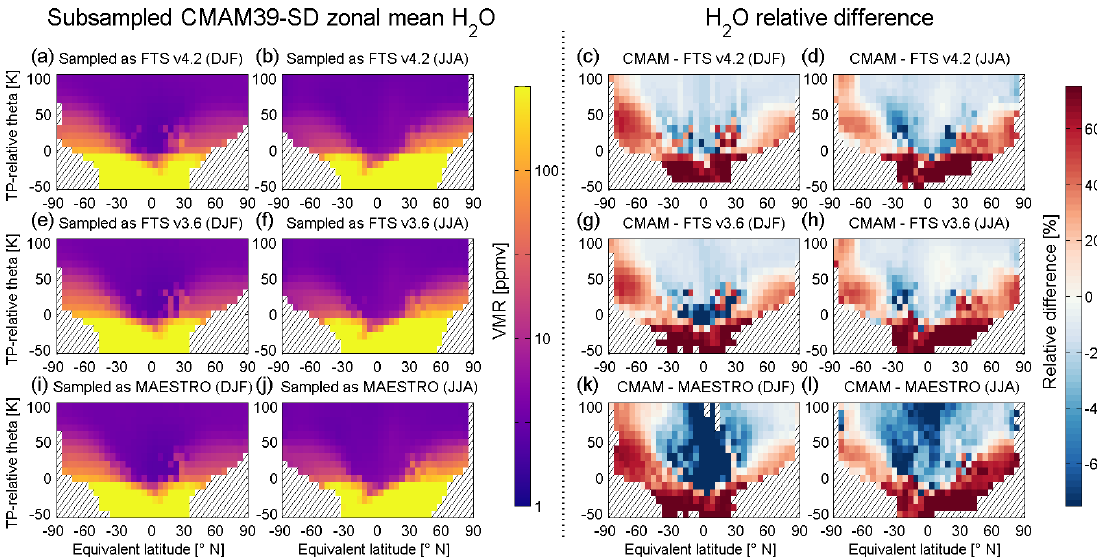
Figure 2. Comparisons between the CMAM39-SD model simulation, subsampled to the times and locations of the ACE-FTS v4.2 (a–d) , ACE-FTS v3.6 (e–h) , and MAESTRO (i–l) measurements and the satellite datasets. The zonal-mean multiyear-mean subsampled climatolo- gies used for the comparisons are shown for DJF (a, e, i) and JJA (b, f, j) , with the label in each plot giving the instrument measurement pattern the model is sampled with. Water vapour relative differences (%) between measurement climatologies and the CMAM39-SD refer- ence climatologies calculated using Eq. (2), as outlined in Sect. 3.2, are shown in the third (DJF) and fourth (JJA) columns. The colour scale of the third and fourth columns is chosen to maximize visibility; however some extreme differences can be obscured by this choice. Note the addition of hatching to the plots where there are no data